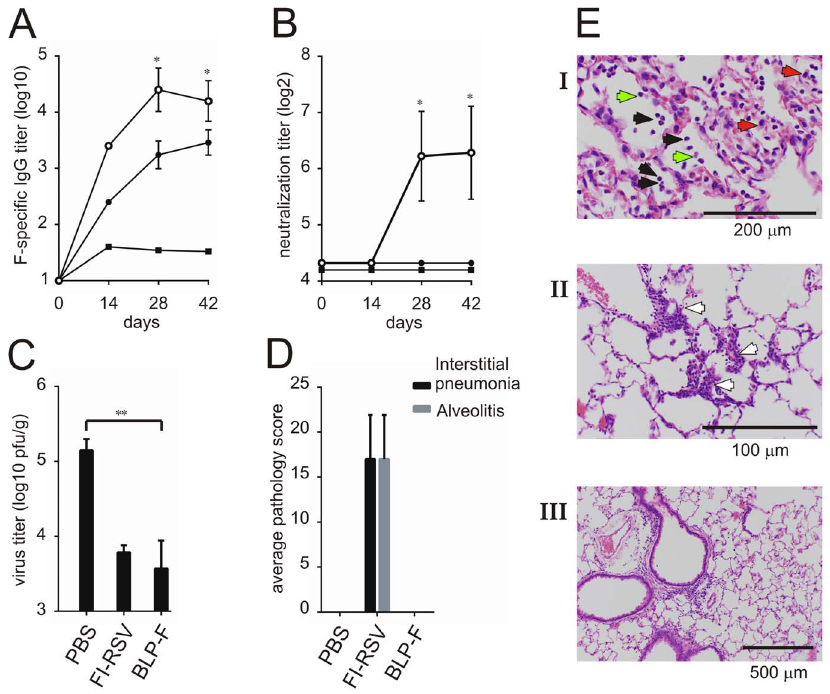
N Figure 8. Immunization, challenge studies and lung pathology post challenge in cotton rats. Cotton rats (N=5) were (mock-)vaccinated ) with 14 day intervals followed by a three times (starting at day 0) with either intranasally with BLP-F ( # ), PBS ( & ) or intramuscularly with FI-RSV ( challenge with RSV/A/long (10 6 pfu) at 14 days after the last vaccination. A) Serum IgG titers after 0 (day 0), 1 (14 days), 2 (28 days) and 3 (42 days) immunizations. B) RSV neutralization titers in cotton rat sera before (day 0) and 2 weeks after each immunization (days 14, 28, 42). C) Virus titers in the lungs at 5 days after challenge. The limit of detection is 200 pfu/gr. D) 5 days post challenge the lungs were harvested for pulmonary histopathology examination. Interstitial pneumonia and alveolitis were scored as described in the Materials and Methods. Standard error of the mean (SEM) is indicated by the error bars. The group receiving BLP-F was compared with the other groups using a Mann-Whitney U test (* P # 0.05; ** P # 0.01). The asterisks in A and B indicate a significant difference between the group receiving BLP-F and the other two groups except for one of the asterisks in A (day 42), which only indicates a significant difference between the groups that received BLP-F and PBS. E) Examples of hematoxylin and eosin-stained lung tissues of animals vaccinated with FI-RSV (top [I] and middle [II] picture) or BLP-F (bottom picture[III]). The black, red and green arrows point at granulocytes, macrophages, and lymphocytes, respectively. The white arrow indicates the widening of the alveolar walls due to the cell infiltration Figure S1 Sequences of the GCN4 trimerization domain and the tags used. The carboxy-terminal residues of the RSV F protein ectodomain are shown in blue. The triple Strep-tagII (ST3; italic, green), GCN4 trimerization domain (red, bold) and the LysM domain (underlined, including LysM linker sequences) are indicated. F proteins containing ST3 were used in the in vitro analysis, while the LysM domain-containing proteins lacking the ST3 tag were used for BLP binding.